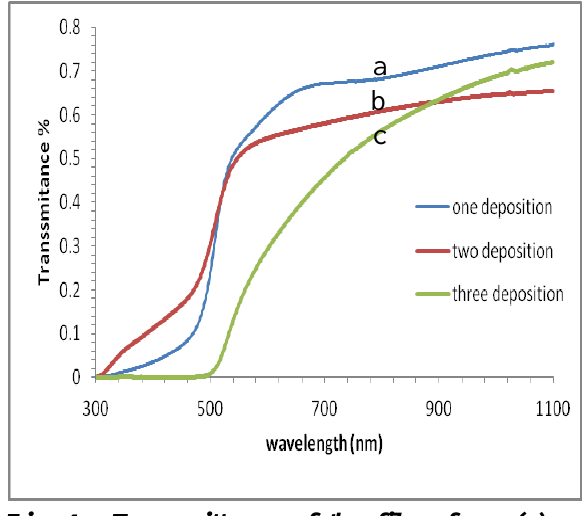
Fig. 4: Transmittance of the films for ; (a) one deposition (b) double deposition and (c) after triple